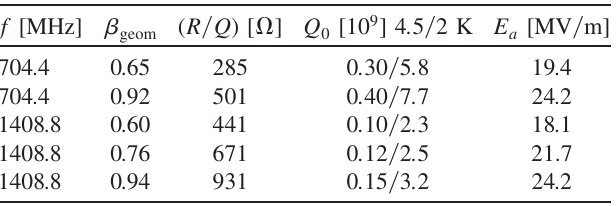
TABLE XII. Expected parameters of superconducting cavities at 704.4 and 1408.8 MHz.